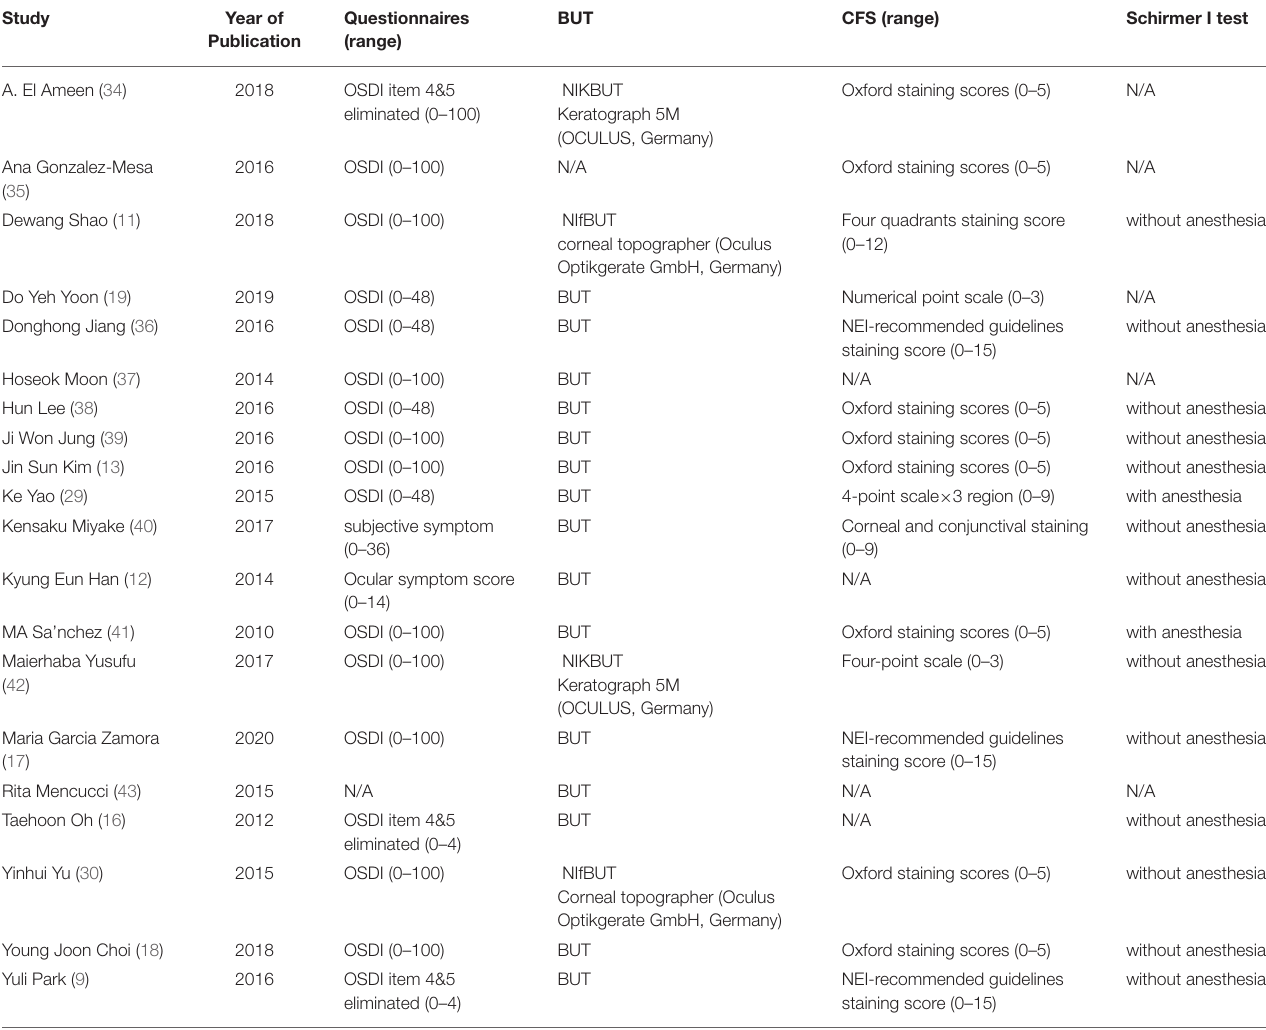
TABLE 2 | Methods that the included studies used to report ocular surface variables.